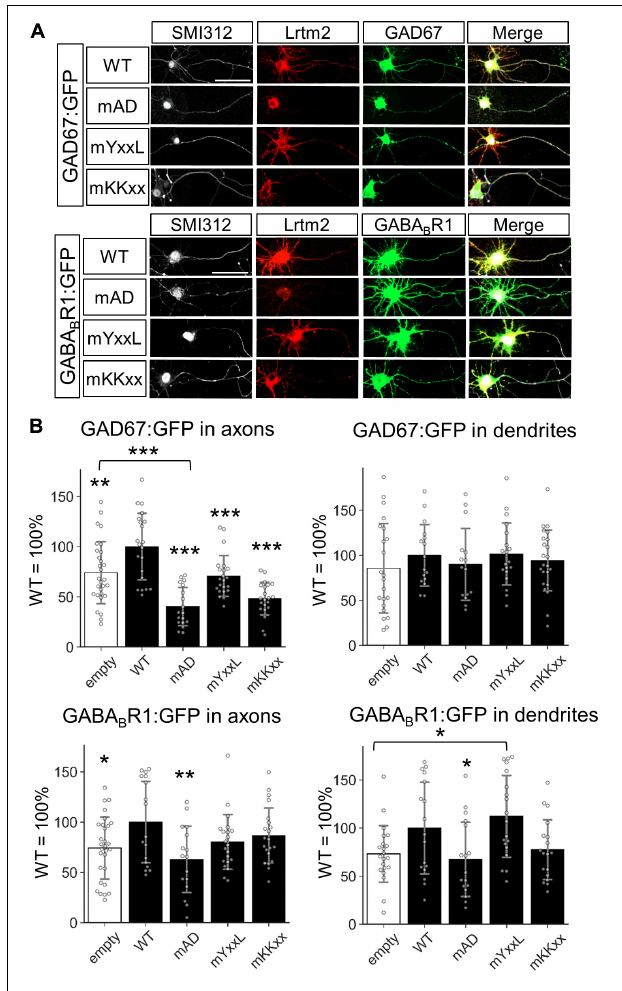
FIGURE 11 | Lrtm2 overexpression enhances axon targeting of GAD67:GFP and GABA B R1:GFP. Cultured hippocampal neurons are transfected with empty, Lrtm2 or its mutant-expressing plasmid with the GAD67:GFP or GABA B R1:GFP expressing plasmid. (A) Representative images. (B) The distribution of the GFP fusion proteins in the axon ( left , defined as a ratio of GFP-positive area to the SMI312-positive area) or dendrites ( right , defined as a ratio of GFP-positive area to MAP2-positive area) is examined. n = 15–23 cells for each combination of the expression constructs. Error bars , SD. Gray circles indicate the individual value of each cell. Scale bars , 50 µ m. Representative images for MAP2 immunostaining are indicated in Supplementary Figure 13 . * p < 0.05; ** p < 0.01; *** p < 0.001 in * p < 0.05; ** p < 0.01; *** p < 0.001 in ANOVA and post hoc Dunnett test, compared to WT values unless otherwise